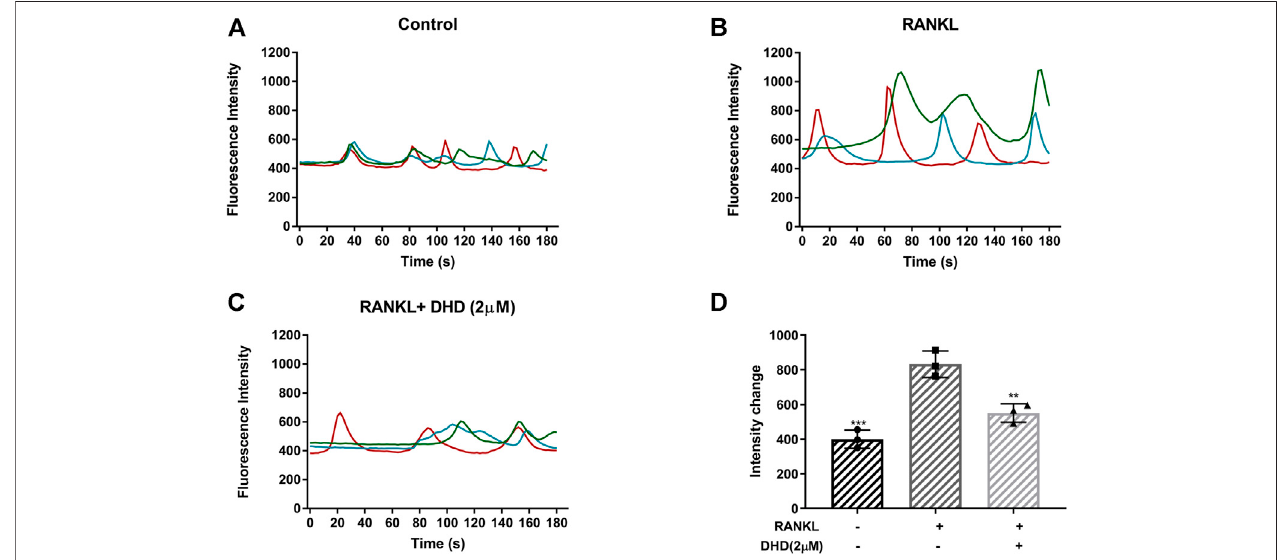
FIGURE8| DHDinhibitsRANKL-induced calciumoscillations.Representativeimagesof fl uorescence intensityofintracellular Ca 2+ oscillation in (A) RANKLgroup, (B) controlgroup,and (C) RANKL +DHD(2 μ M)group.Differentcoloredlinesineachimageindicatetheresultsofthreeindependentexperiments. (D) The fl uorescence intensity of calcium oscillation in three groups was quantitatively analyzed ( n = 3). Fluorescence intensity change was measured by subtracting the minimum peak intensity from the maximum peak intensity.